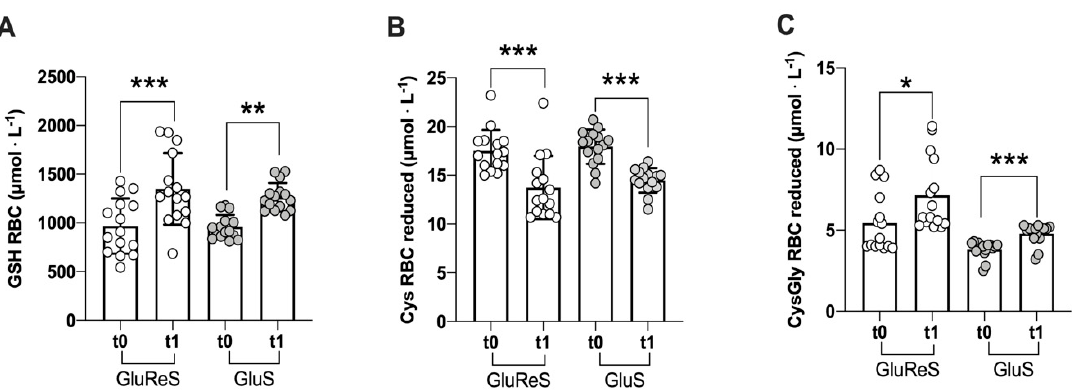
Figure 1. Scatter dot plot of reduced thiol species measured in erythrocytes before (t0) and after 8 weeks (t1) of dietary supplementation with GluReS (Glutathione and Resveratrol Synthesis) or GluS (Glutathione Synthesis). ( A ) reduced glutathione (GSH), ( B ) reduced cysteine (Cys), ( C ) reduced cysteinylglycine (CysGly); RBC = red blood cells. Data are expressed as the mean ± SD. Changes over time (t1 vs. t0) were significant at: * p < 0.05; ** p < 0.01; *** p < 0.001.